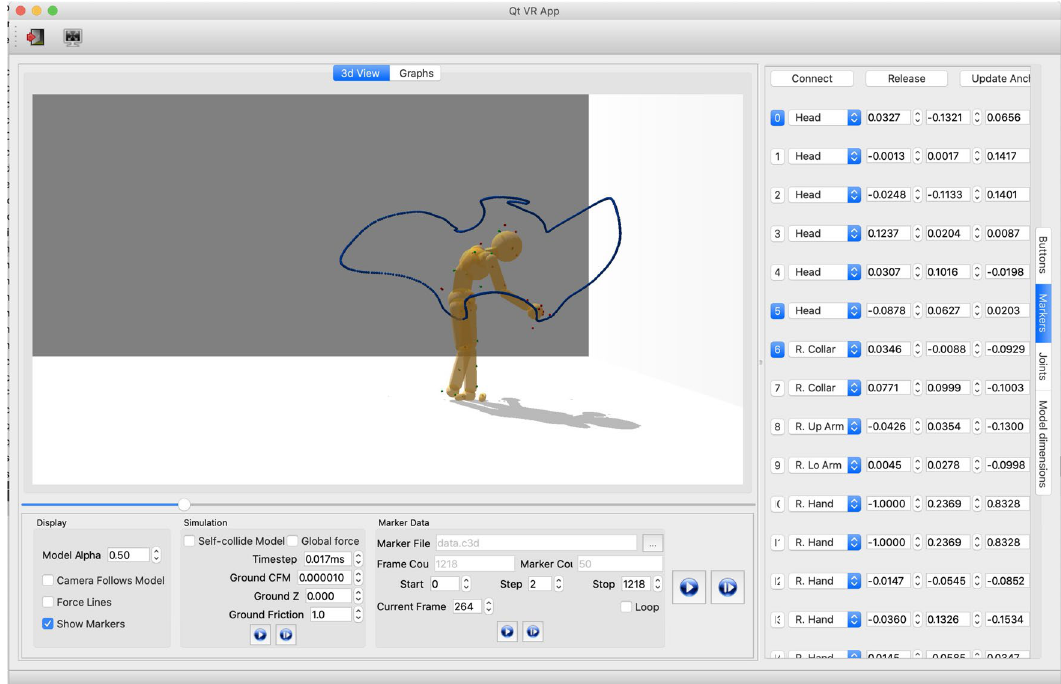
Figure 10. The analysis tool of using the physics engine to compute inverse kinematics and inverse dynamics 28 . The user interface also supports various visualizations of relevant data and control for analyzing and producing physically-based movements. The programmed parameters of the model consist of its joints and its 3D marker positions. For example, the right column represents the positions of the markers relative to their corresponding body segments, e.g. the first row shows the information of marker1: (1) “1” represents the marker index, (2) “head” means marker 1 is attaching to the “head” body segment, (3) the remaining three float numbers are marker1’s relative position.